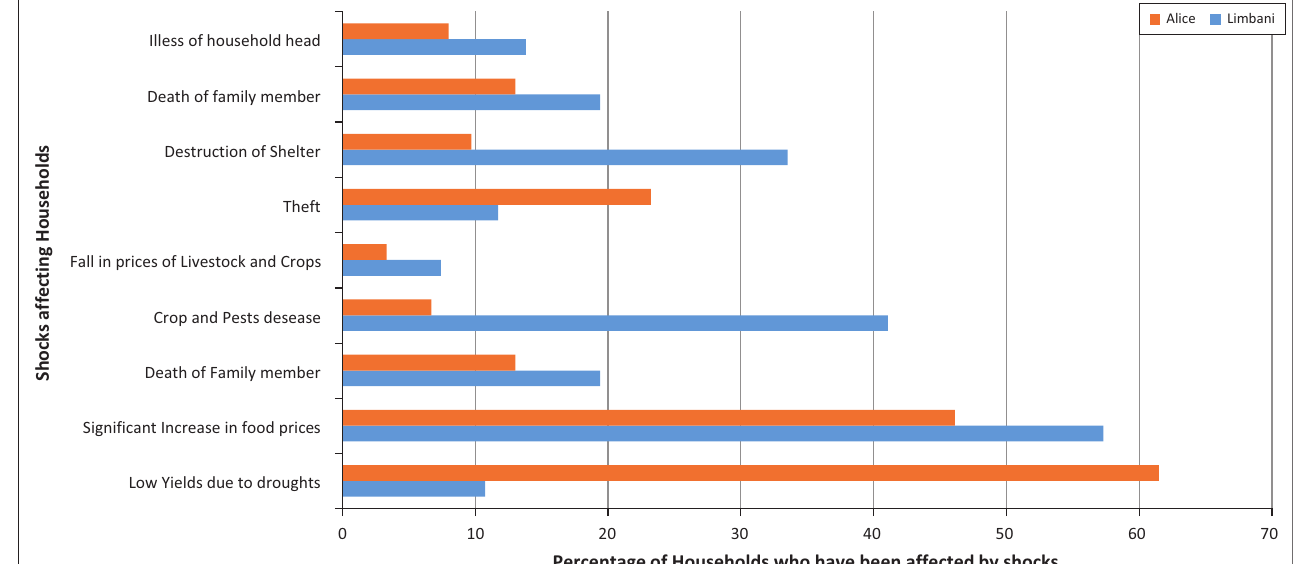
FIGURE 9: Major household